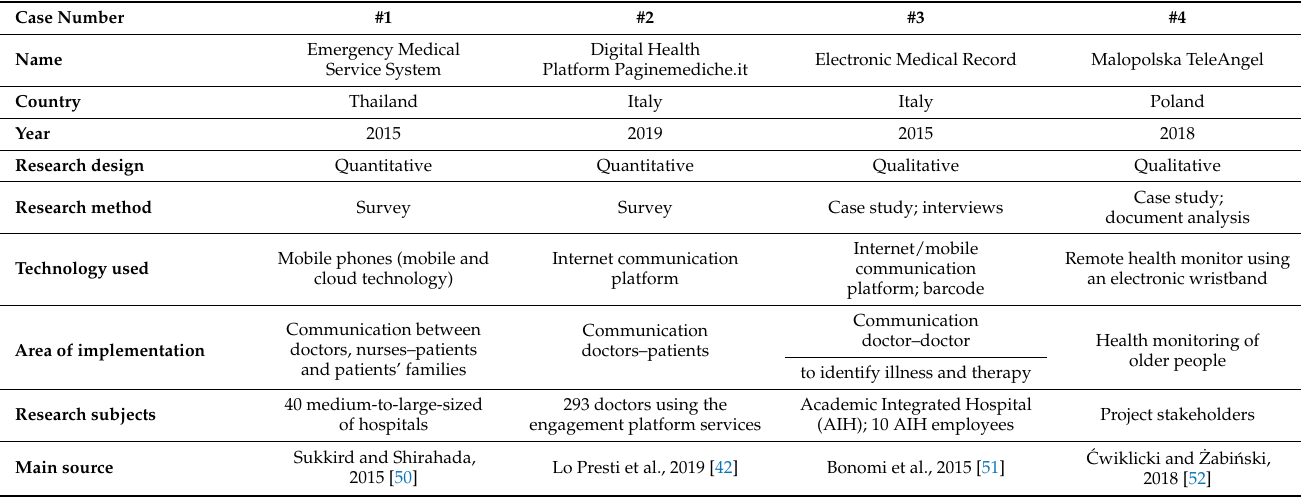
Table 3. Synthesis of